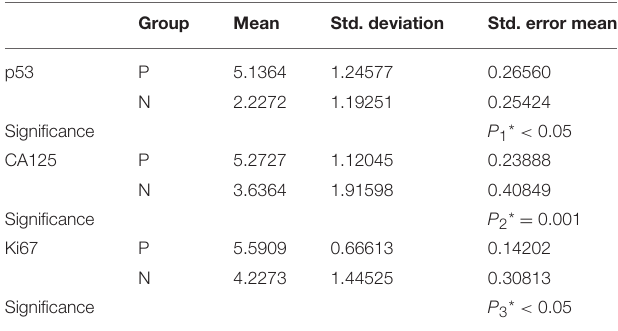
TABLE 1 | Results of t test showing the immunoreactivity scores’ correlations between positive group and negative group.